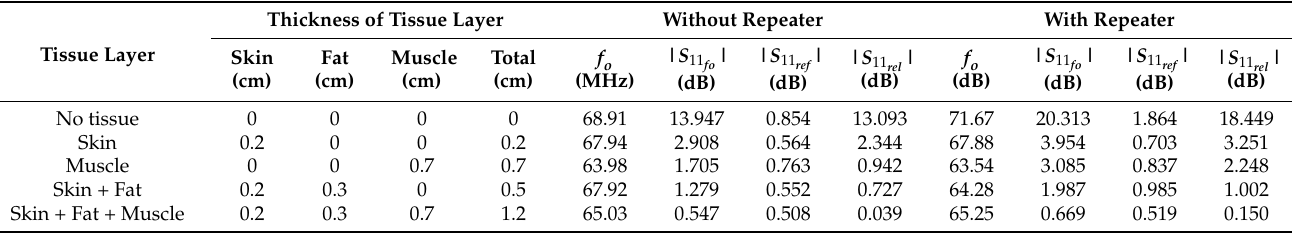
Table 3. Magnitude of relative return loss ( S 11 rel ) between the sensor and the readout coil for different thicknesses of ovine tissue